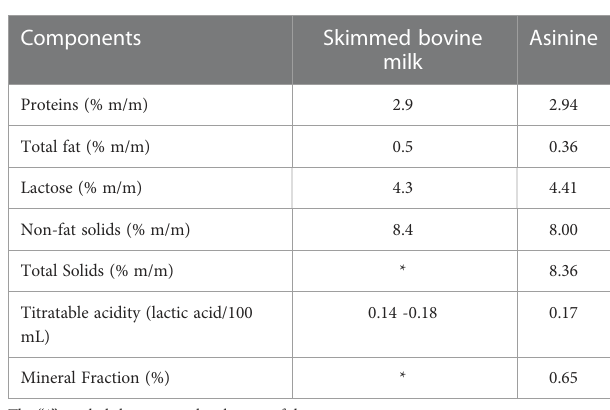
TABLE 1 Means of nutritional values found in samples of asinine milk and skimmed bovine milk used to supplement piglets before and after